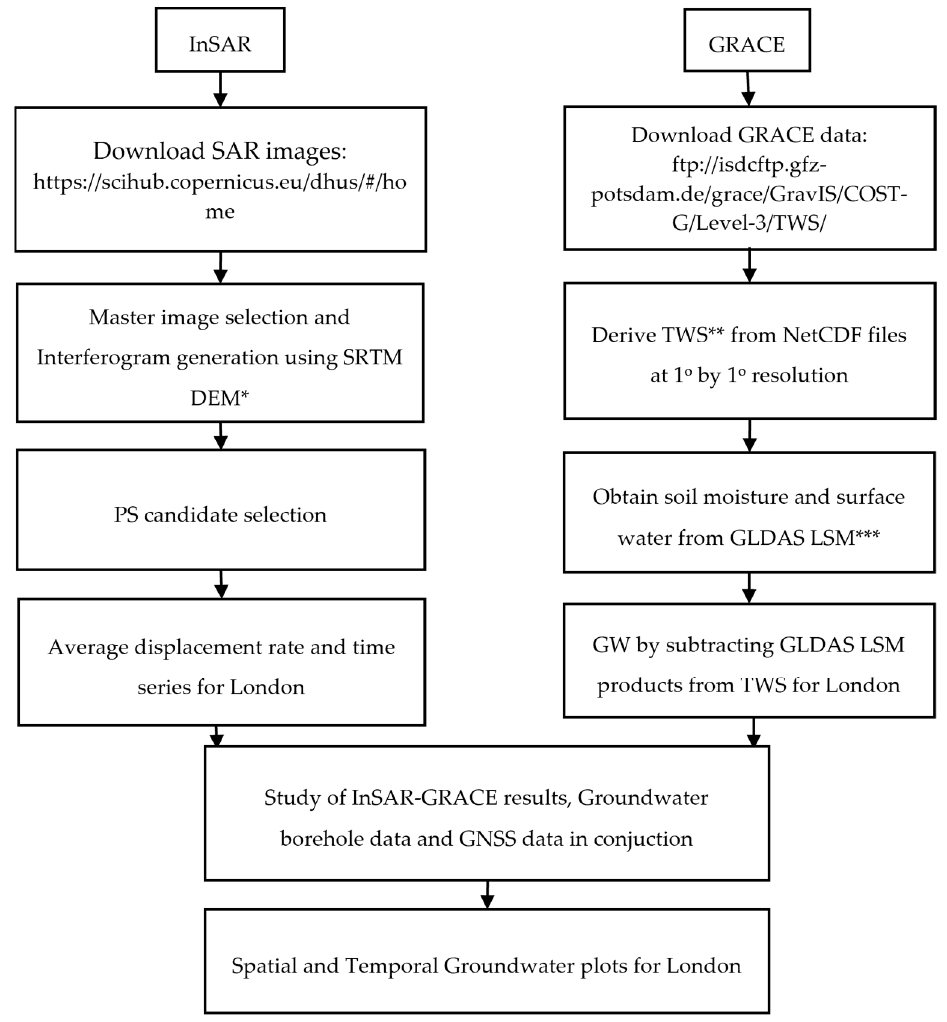
Figure 2. Methodology used for the research. (* SRTM DEM - Shuttle Radar Topography Mission Digital Elevation Model, ** TWS - Terrestrial Water Storage, *** LSM -Land surface Model).